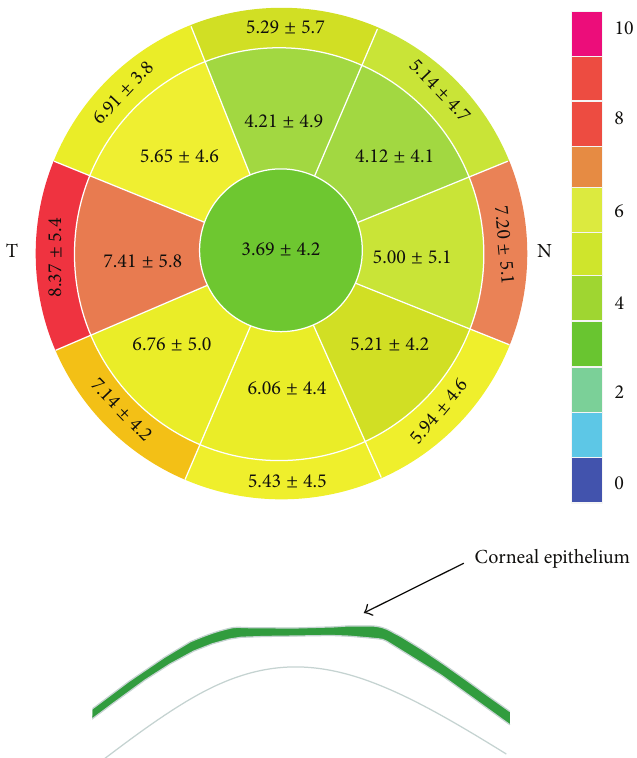
Figure 3: Epithelial thickening at each sector 6 months postoperatively (mean ± standard deviation, 𝜇 m).